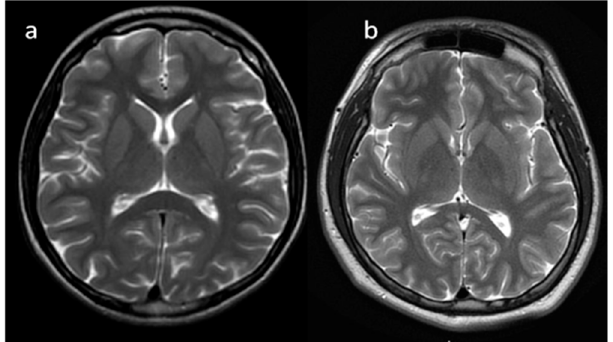
Figure 3. ( a , b ). Completion of myelination on brain MRI and differences in signal intensity between the basal ganglia and the surrounding brain tissues (axial T2-WI).